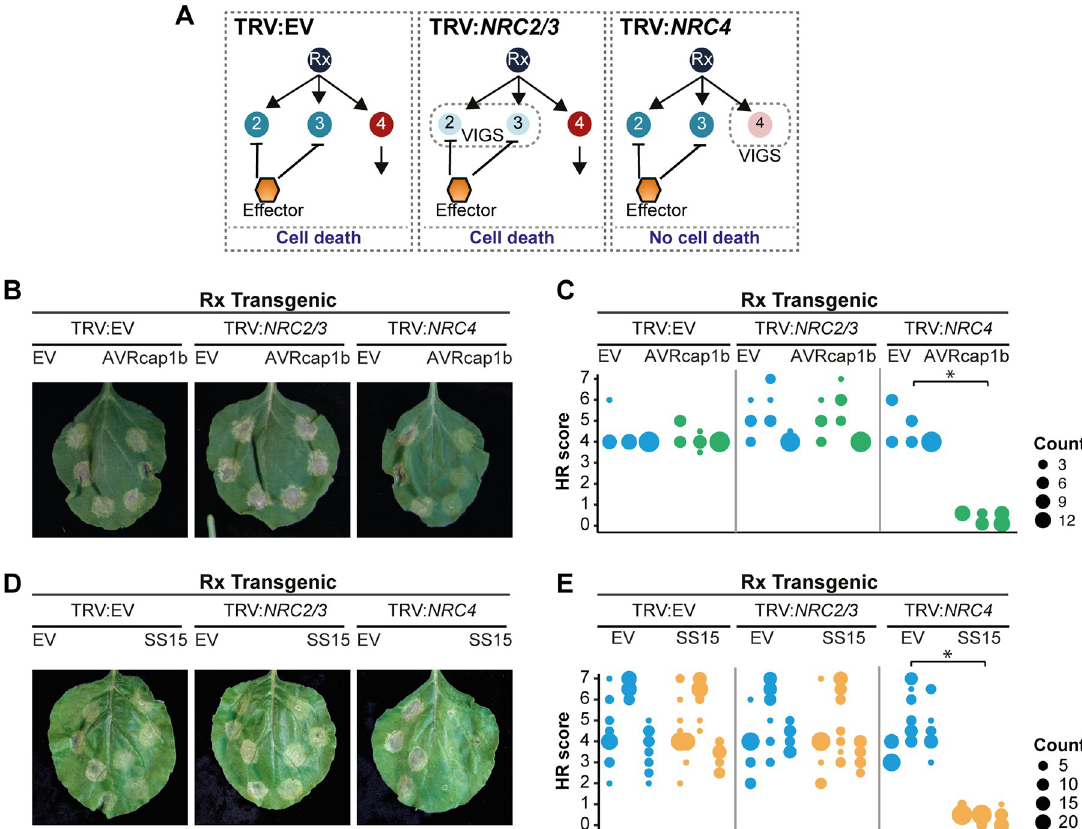
Fig 4. AVRcap1b and SS15 suppress Rx-mediated cell death in NRC4 -silenced Rx-transgenic Nicotiana benthamiana plants. (A) A schematic representation of the silencing and infiltration strategy undertaken. Photo of representative N . benthamiana leaves showing HR after coexpression of (B) EV or AVRcap1b and (D) EV or SS15 in TRV:EV, TRV: NRC2/3 , and TRV: NRC4 silenced Rx-transgenic N . benthamiana plants, where EV was used as a negative control. Silencing treatments (TRV:EV, TRV: NRC2/3 , and TRV: NRC4 ) are indicated above leaf panels. Plants were photographed 5 days after agroinfiltration. Cell death response was scored 5 days after agroinfiltration (S7 Data) (C) EV and AVRcap1b and (E) EV and SS15 and presented as dot plots, where dot colour represents either EV (blue), AVRcap1b (green), or SS15 (orange) and dot size is proportional to the number of samples with the same score (count). The experiment was independently repeated 3 times. Each replicate is represented by different columns within each silencing treatment for either EV, AVRcap1b, or SS15. Statistical tests were implemented using the besthr R library [41]. We performed bootstrap resampling tests using a lower significance cutoff of 0.025 and an upper cutoff of 0.975. Mean ranks of test samples falling outside of these cutoffs in the control samples bootstrap population were considered significant. Significant differences between the conditions are indicated with an asterisk ( � ). Details of statistical analysis are presented in S7 Fig. EV, empty vector; HR, hypersensitive response; VIGS, virus-induced gene